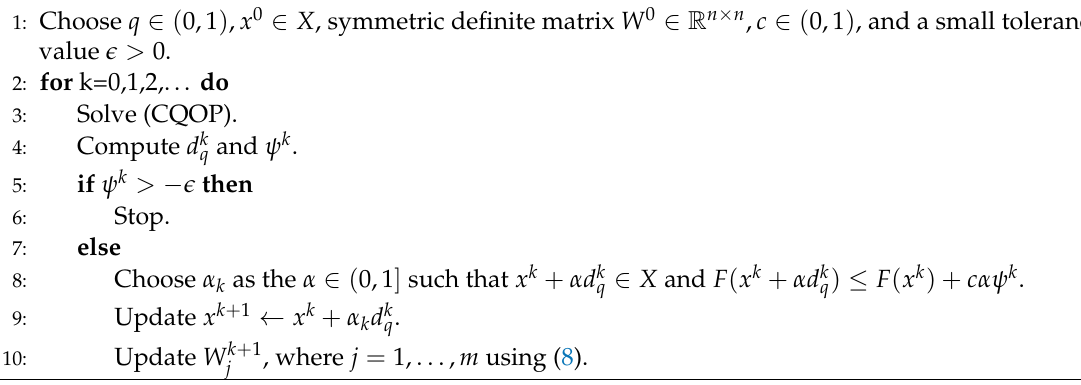
Algorithm 2 q -Quasi-Newton’s Algorithm for Unconstrained Multiobjective ( q